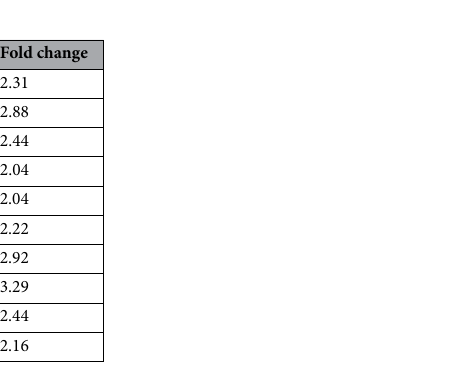
Table 2. Up regulated genes in ERα-KO